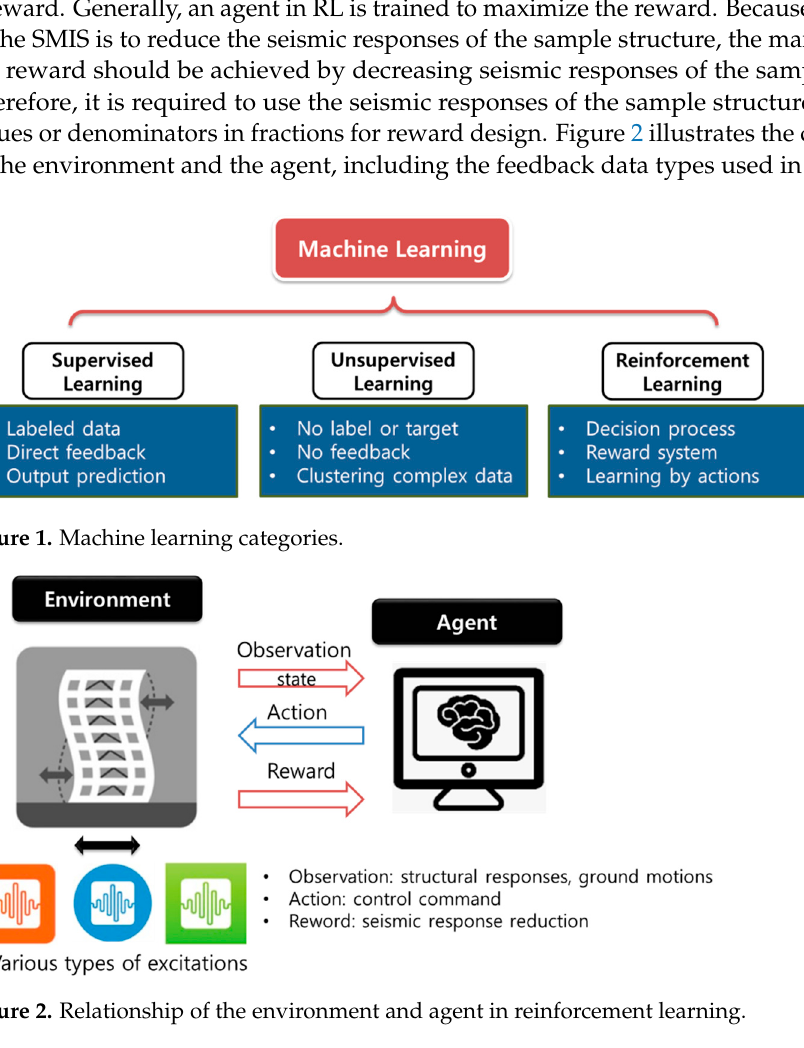
Figure 1. Machine learning categories.